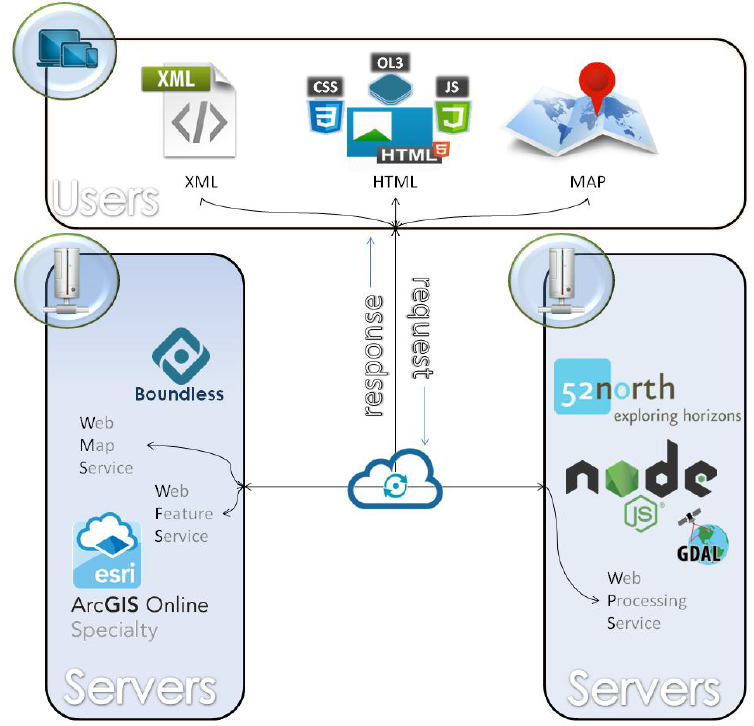
Figure 1. Functional architecture of a system exploiting geospatial web services (GWSs).